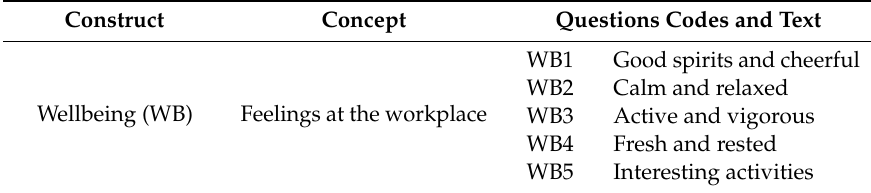
Table 2. EWCS variables linked to the wellbeing construct.